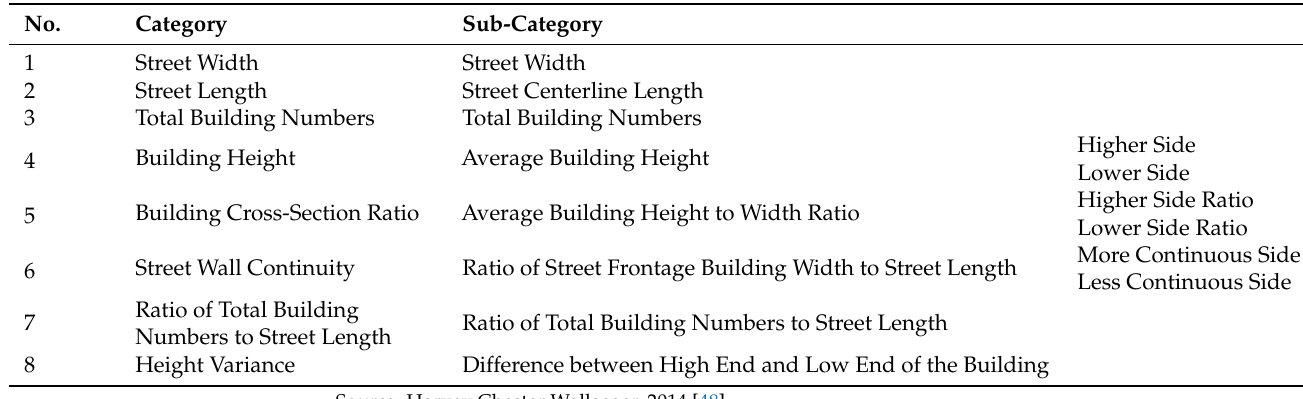
Table 2. Quantitative Street Space Indicators.